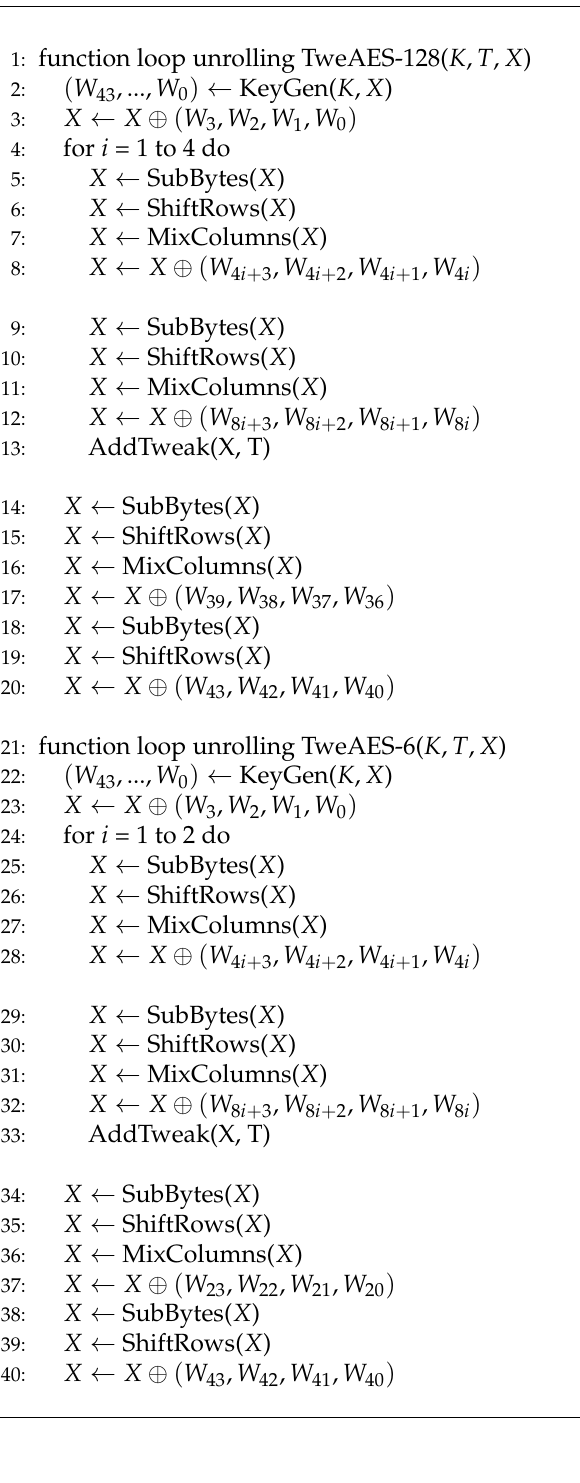
Algorithm 5 TweAES-128, TweAES-128-6, TweGIFT-128 proposed by applying loop unrolling